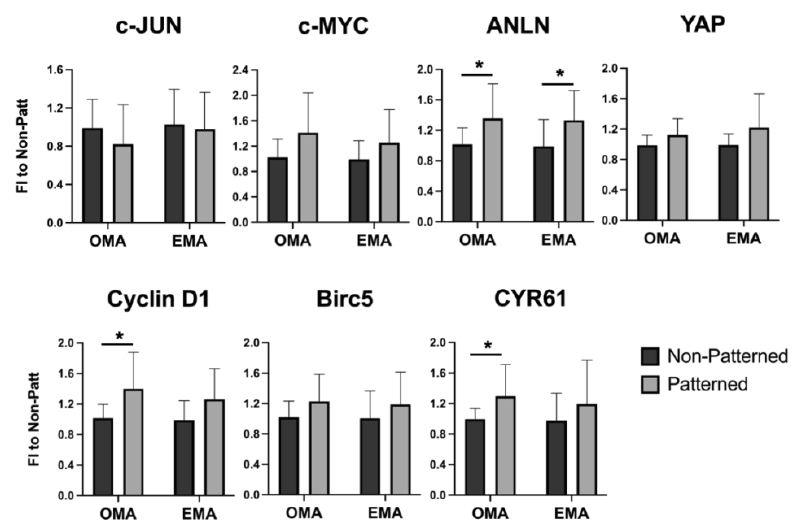
by the cell organization.